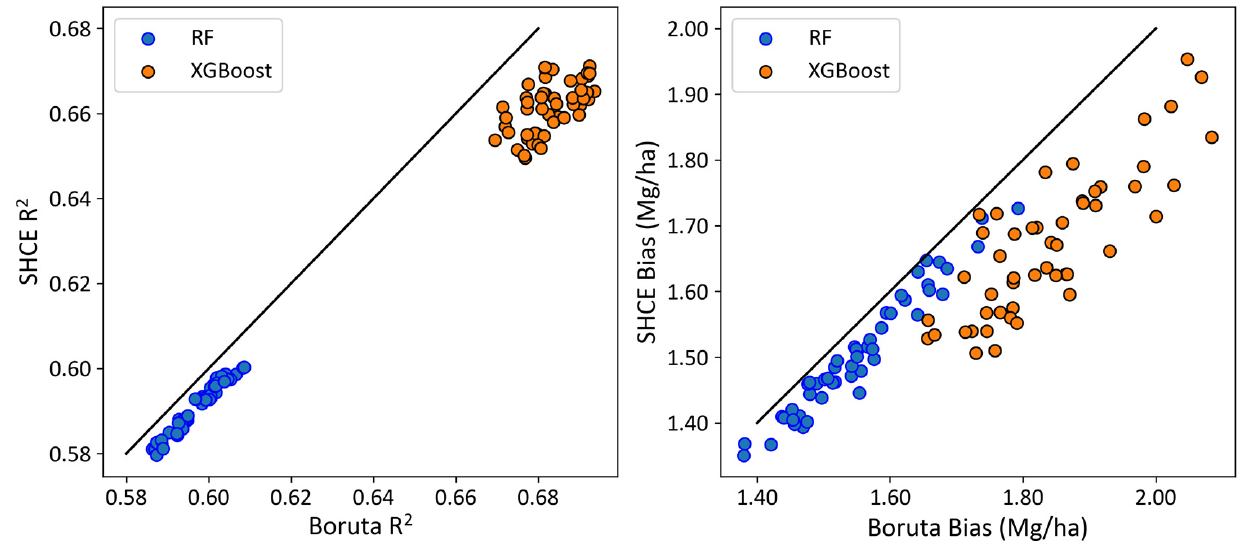
Figure 7. Forest AGB prediction accuracy using Boruta selected subsets and SHCE selected subsets as indicated by R 2 and bias for comparison.